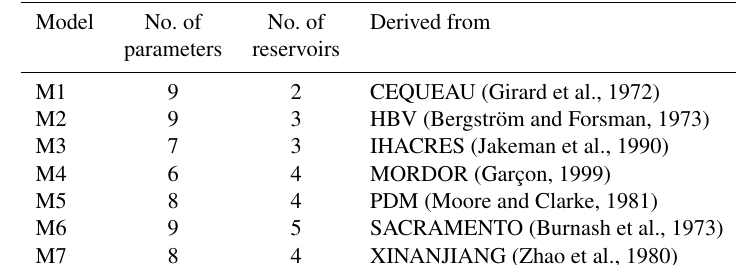
Table 2. Main characteristics of the seven lumped models. Modified from Seiller et al. (2012).